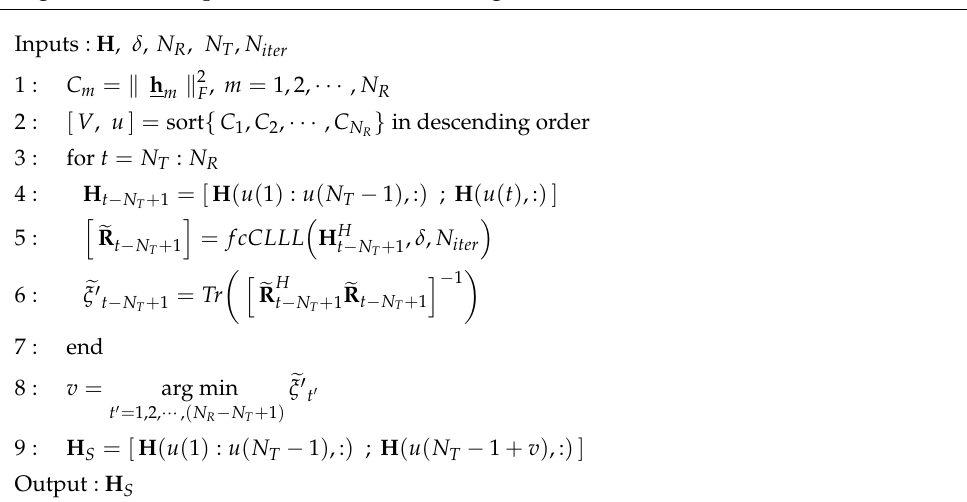
Algorithm 1: Suboptimal LR-RAS Selection